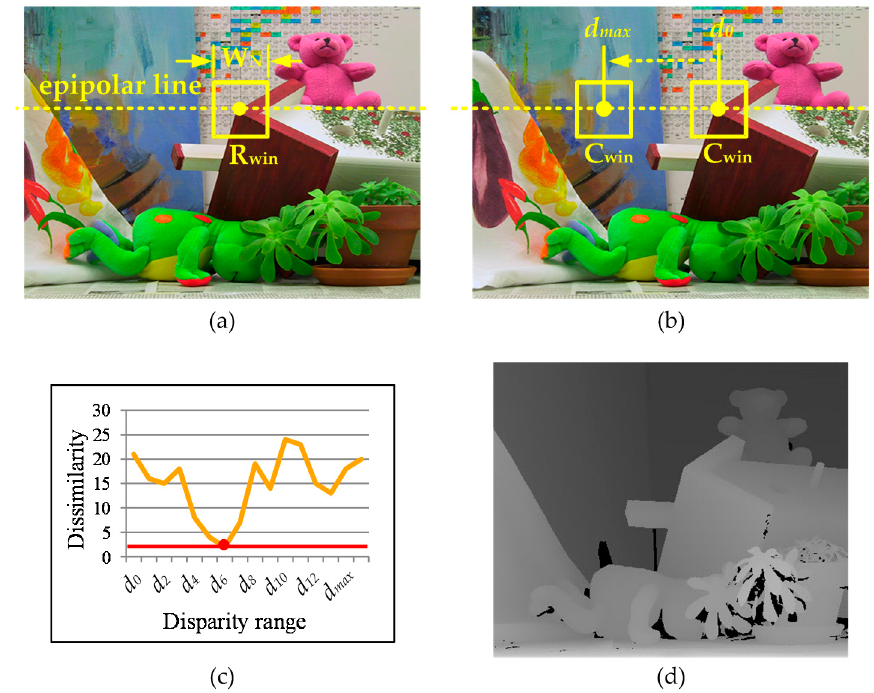
Figure 1. ( a ) Left image (R win : reference window); ( b ) right image (d x : disparity range, C win : candidate window); ( c ) dissimilarity between R win and C win ; and ( d ) a depth map.